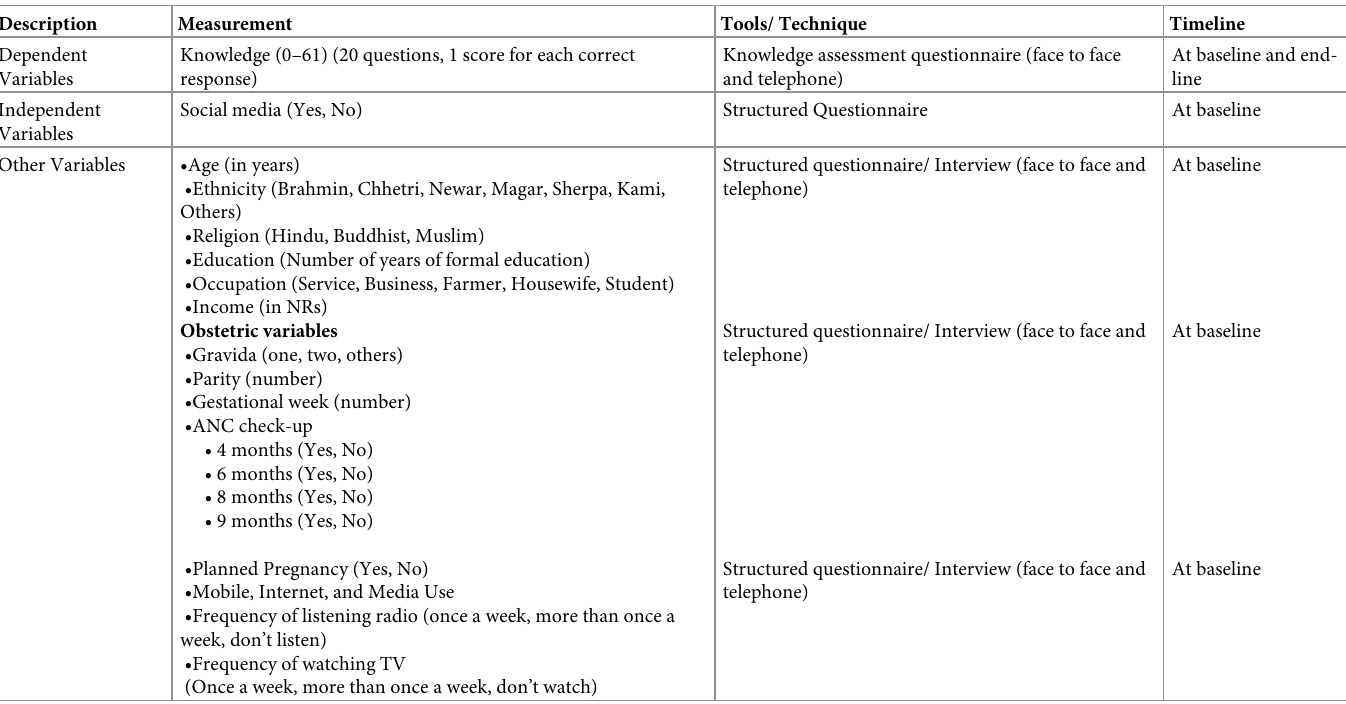
Table 2. Data collection tools and schedule of different variables included in the social media-based